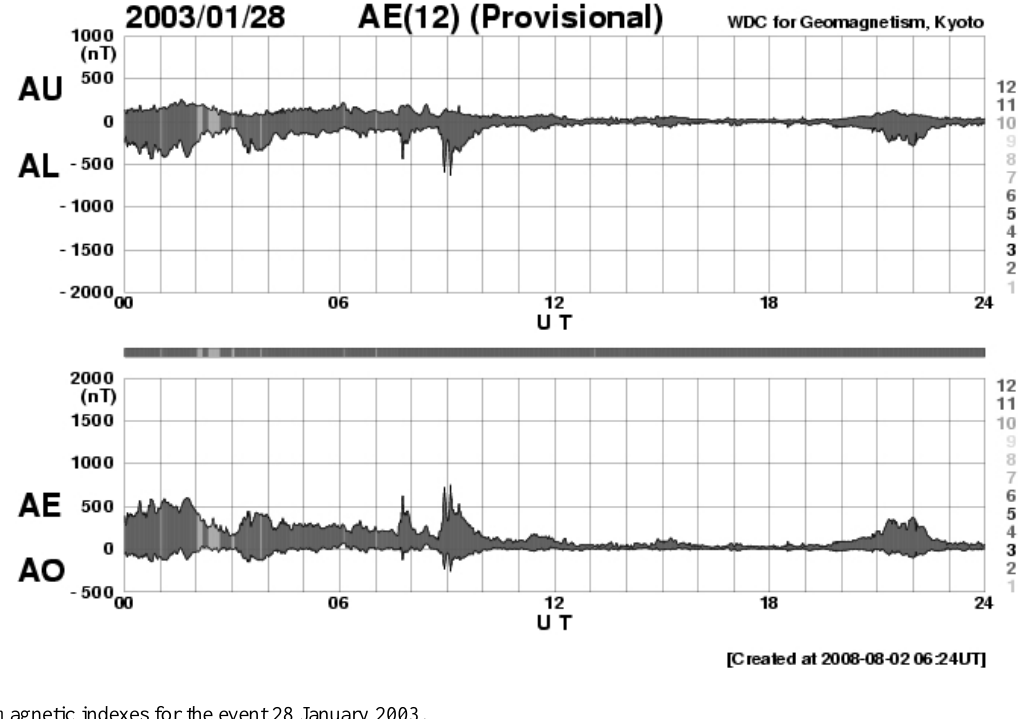
Fig. 1. Geomagnetic indexes for the event 28 January 2003.